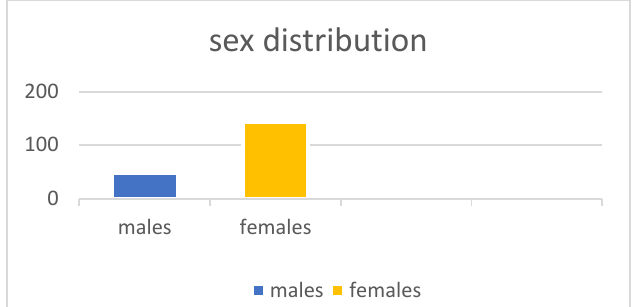
Figure.1: sex distribution in the study sample.